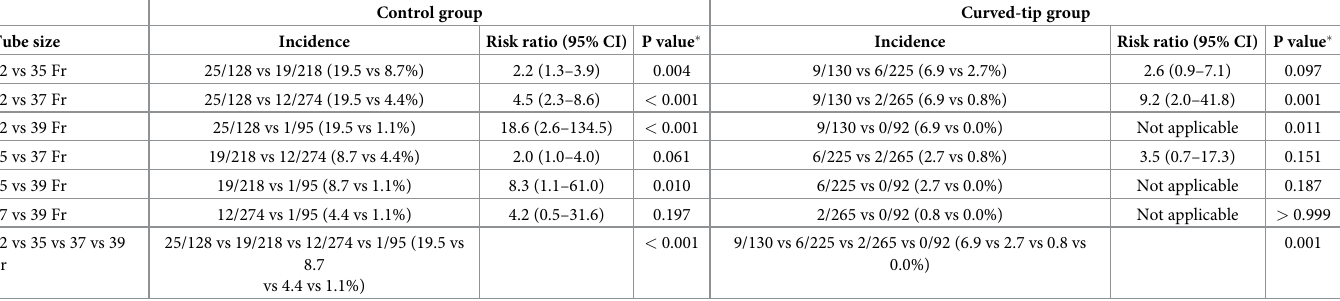
Values are number of patients (percentage). �